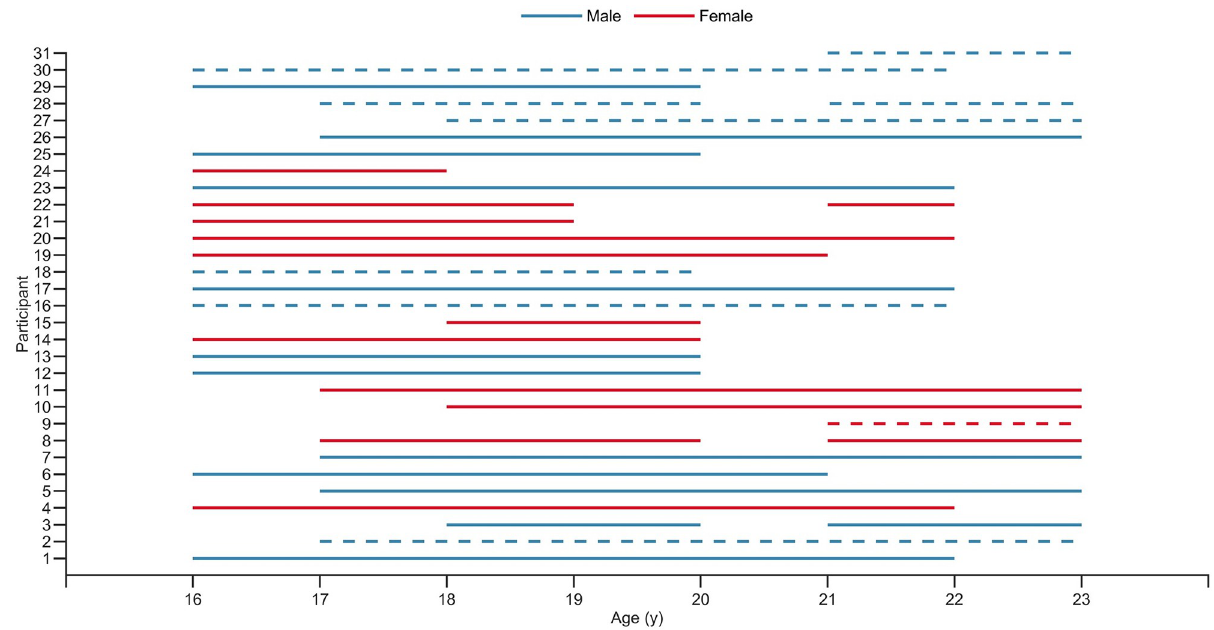
Fig 1. Annual data included in the final analysis for each participant. Solid lines: training and illness data; dashed lines: training data only.